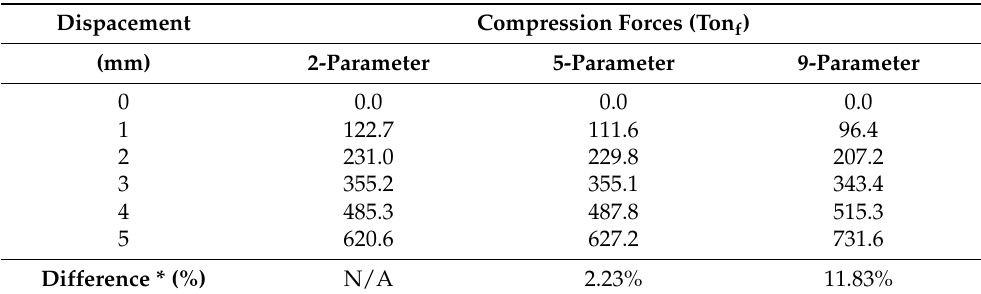
Table 7. Compression force and displacement with respect to the three M-R models through the numerical simulation.